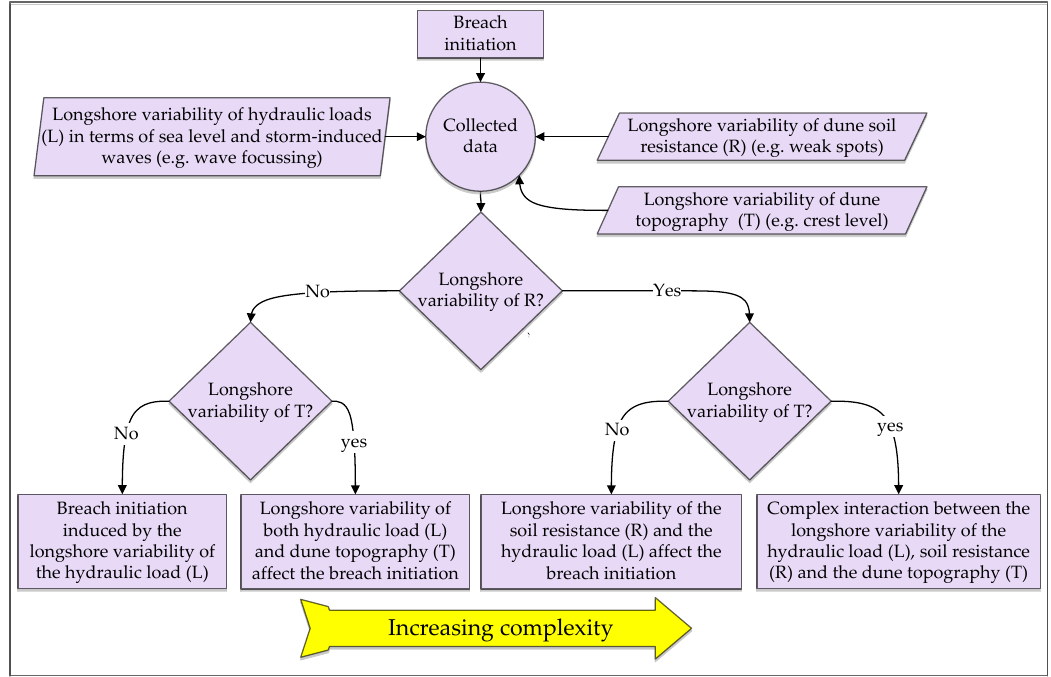
Figure 22. Triggering factors associated with longshore variability for breach initiation along a dune.